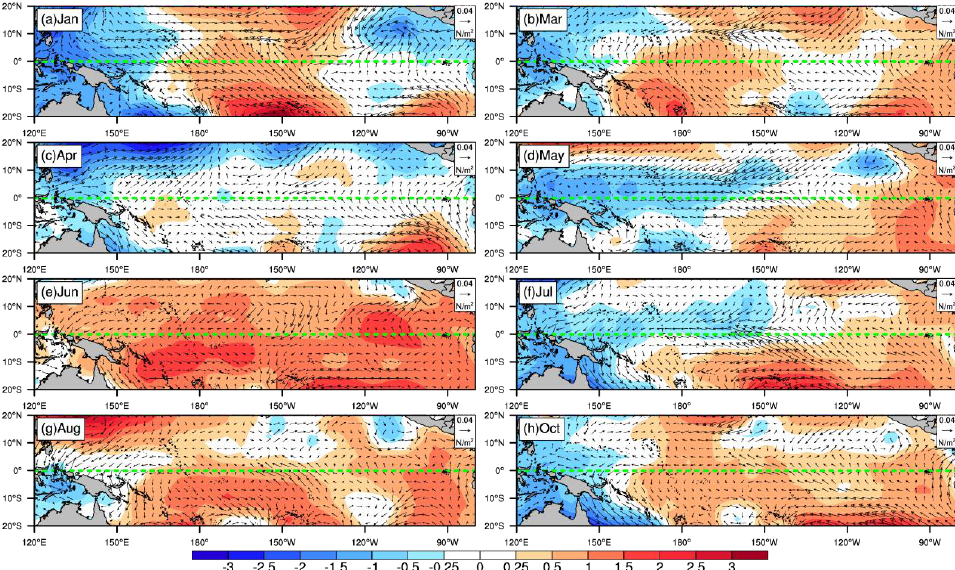
Figure 6. The spatial distribution of the SLP (shading) and wind stress (vectors) anomalies in January, March, April, May, June, July, August, and October 2021. Unit: hPa for SLP; N m − 2 for wind stress.